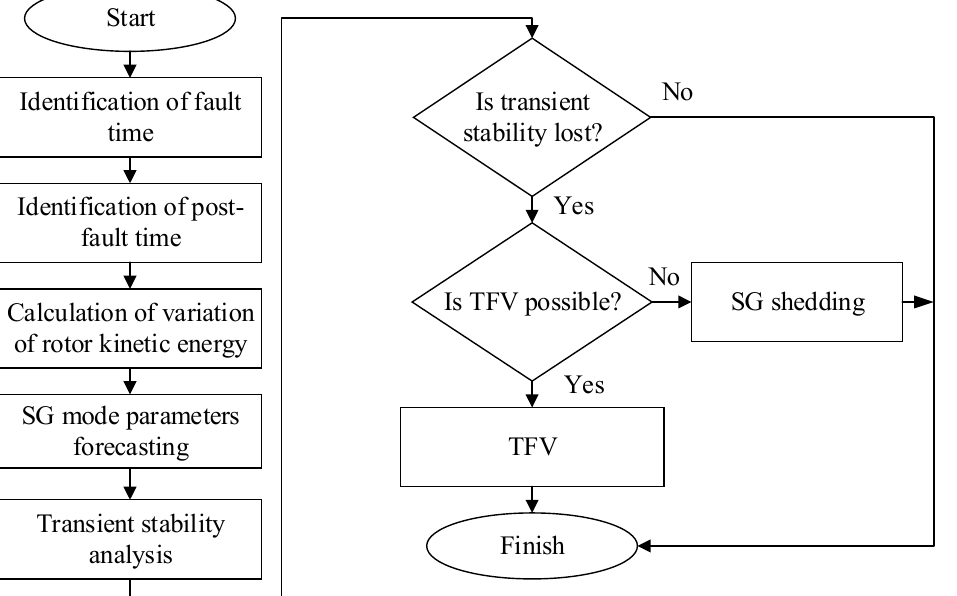
Figure 2. The block diagram of the algorithm of transient stability estimation and TFV control syn ‐ thesis.